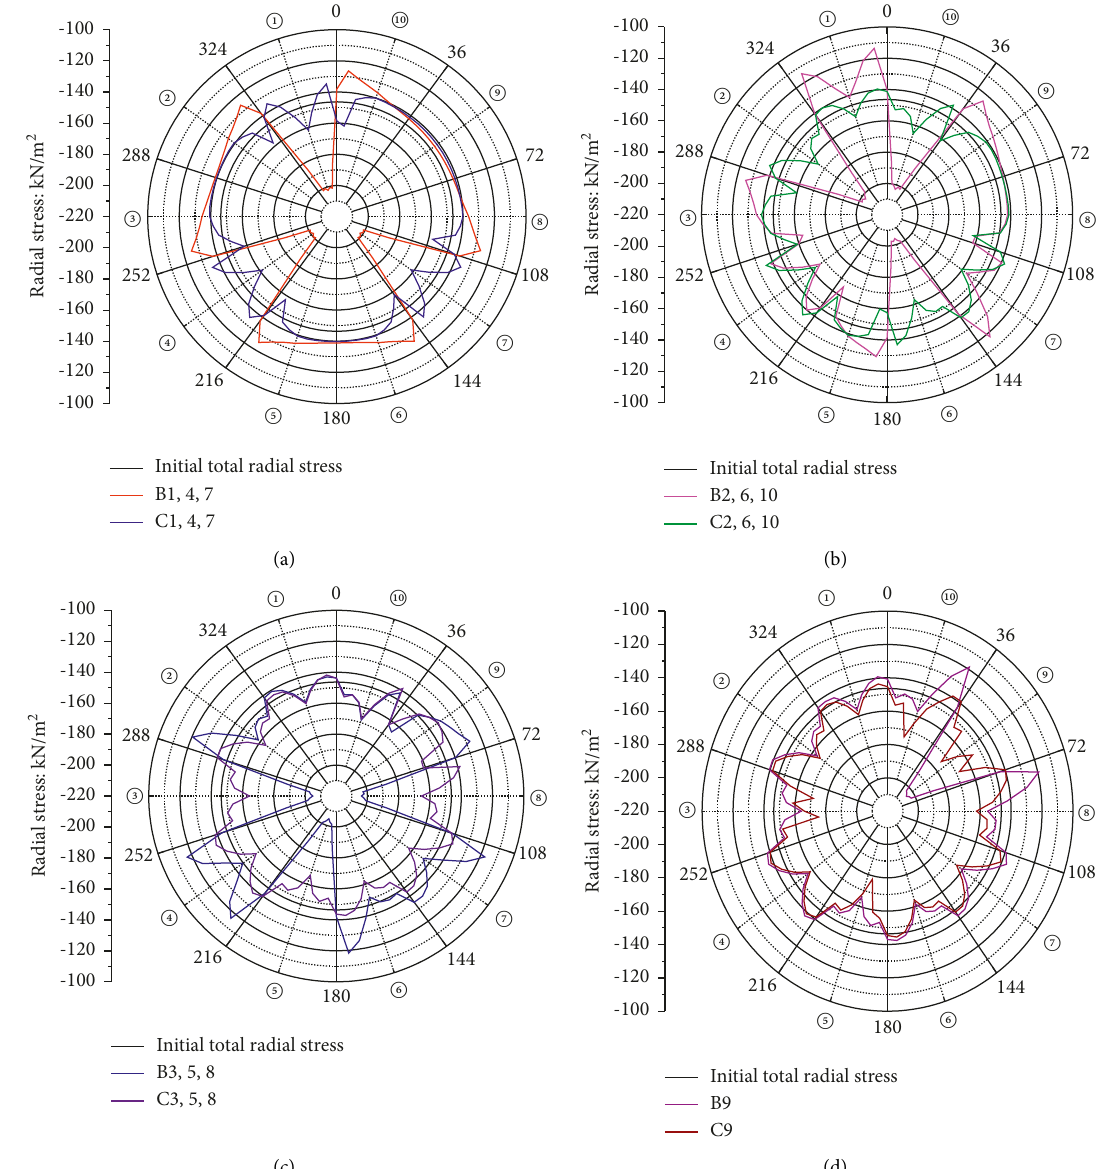
Figure 10: Distribution of radial stress behind all wall on the soil in depth 20.48m for various step of